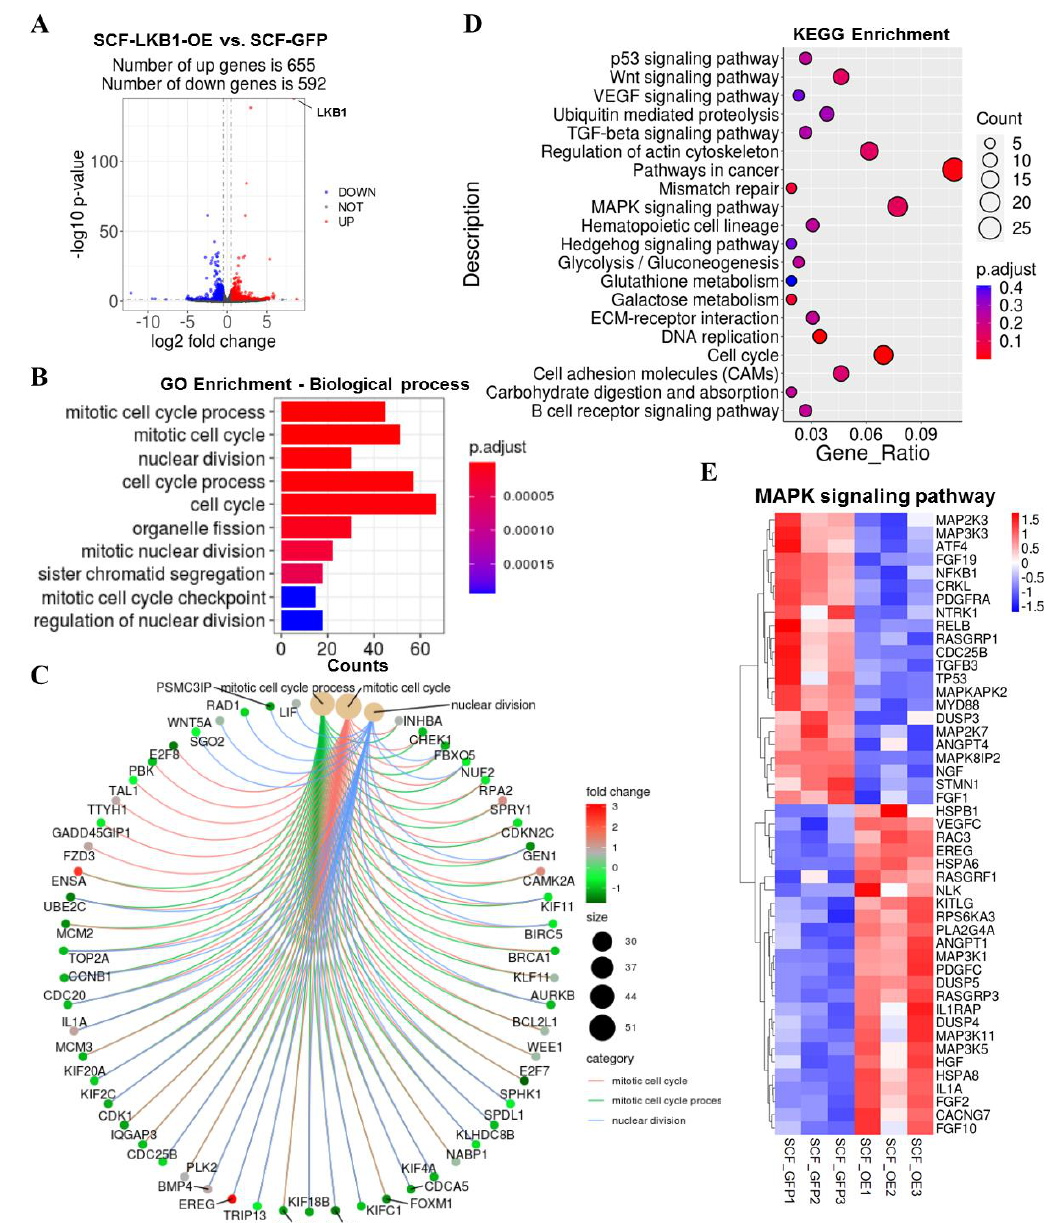
Figure 2. LKB1 overexpression alters the transcriptional profile of SCF adipocytes. ( A ) Log2 (fold change) values in exons of RNA-seq gene bodies in LKB1-overexpressing SCF adipocytes versus controls and the corresponding significance values displayed as -log10 (P-value). The transverse and vertical dotted lines indicate the cutoff value for differential expression (p < 0.05 and Abs (Log2 (fold changes) > 0.5). In total, 655 and 592 genes were identified that had induced (red) or repressed (blue) expression levels by cold exposure. ( B ) Gene ontology (GO) enrichment analysis based on biological processes and enriched terms were visualized by bar plot. The bar color indicates significance, and the corresponding significance values are displayed as P.adjust. The bar length indicates significantly changed gene counts of genes involved in certain categories. ( C ) The cnetplot depicts the linkages of the three most enriched GO terms (mitotic cell cycle process, mitotic cell cycle, nuclear division) and genes involved in these terms as a network. The yellow dots indicate enriched GO terms, and the size of each dot indicates gene counts involved in certain GO terms. The smaller dots indicate genes involved in these terms. The color of each smaller dot indicates genes with log2(fold change) values in LKB1-overexpressing SCF adipocytes versus controls. ( D ) Functional enrichment analyses using Kyoto Encyclopedia of Genes and Genomes (KEGG) pathways. The triangle size indicates gene